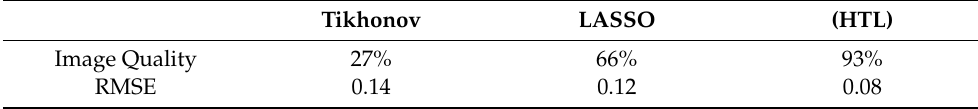
Table 2. Performance evaluation for Tikhonov, LASSO, and HTL.